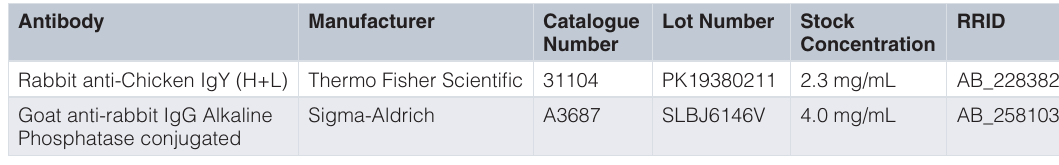
(Table 1). The antibody was isolated through immunospecific purification of antisera from a rabbit IgG-immunised goat. Fol- lowing isolation, the anti-rabbit IgG was conjugated to alkaline phosphatase using glutaraldehyde-based cross-linkage. The anti- body was added to the protein array at a 1/1,000 dilution in 2% (w/v) BSA in tris-buffered saline (TBS) with 0.1%, v/v, Tween 20. Protein arrays Unipex protein arrays were obtained from Source Bioscience Life Sciences (Nottingham, UK). The Unipex arrays comprise of 15,300 fully annotated E. coli clones expressing a total of 7,390 distinct in-frame ORF human recombinant proteins. The Unipex proteins are immobilized under denaturing conditions directly on the PVDF membrane surfaces exposing linear sequence epitopes ideally suited for epitope mapping, antibody profiling and antibody cross- reactivity analyses. The details of protein arrays utilised in this study are provided in Table 2. For general information on Unipex protein arrays please refer to: (http://www.lifesciences.sourcebio-